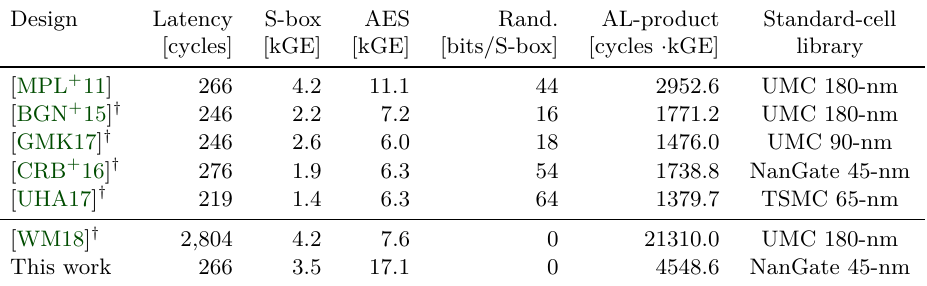
Table 1: Performance evaluation of the proposed AES implementations and comparison with the performance of conventional designs with 1st order security. The entries with † are based on